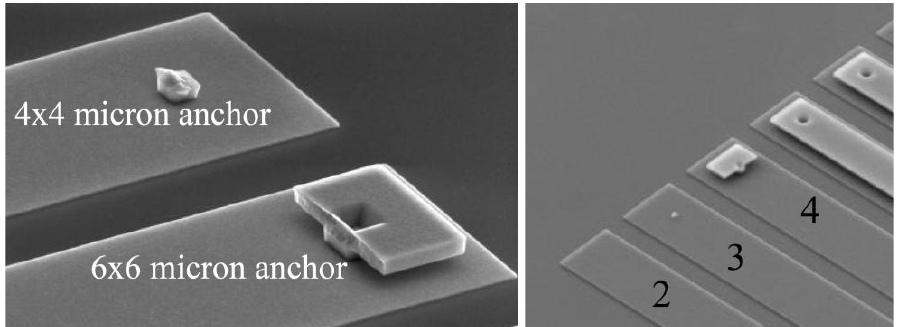
Figure 3. Effect of the anchor size on failure in micro-beams exposed to high- g shocks, after